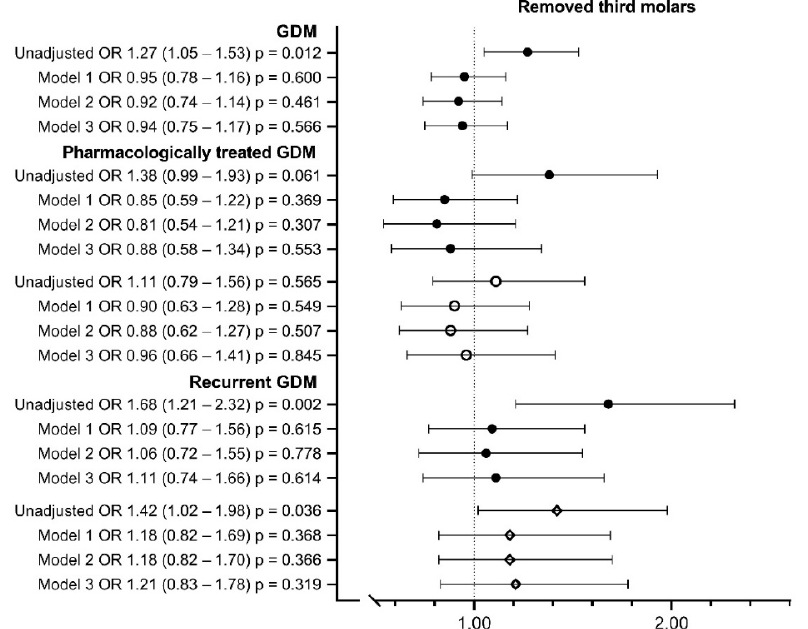
Figure 3. Removal of third molar (yes/no) in women with gestational diabetes. Model 1 includes maternal age at delivery and parity; Model 2 includes Model 1 + pre-pregnancy BMI; Model 3 includes Model 2 + smoking during pregnancy, educational attainment, asthma and insomnia and/or mental disorders. • Compared to controls. ◦ Compared to women with diet-treated GDM. ♦ Compared to women with first-onset GDM. Missing values were 1.1–1.4% in Models 1 and 2 and 5.7–7.3% in Model 3. OR, odds ratio; CI, confidence interval.